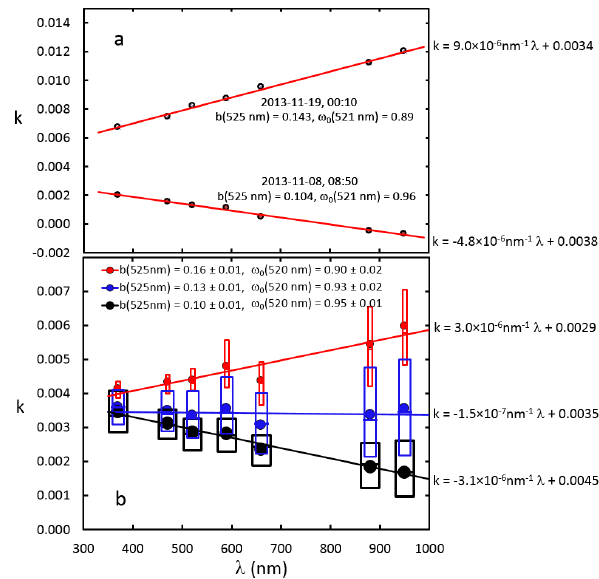
Figure 2. Wavelength dependency of the k factor (a) on 8 and 19 November 2013 and (b) in the whole data after classification into three bins of the green backscatter fraction. In (b) the box plots present the 25th to 75th percentiles, the middle lines the medians and the circles the averages in each bin. In (a) the lines represent linear regression fittings to the individual k factors and in (b) linear regression fittings to the average k in each wavelength and backscat- ter